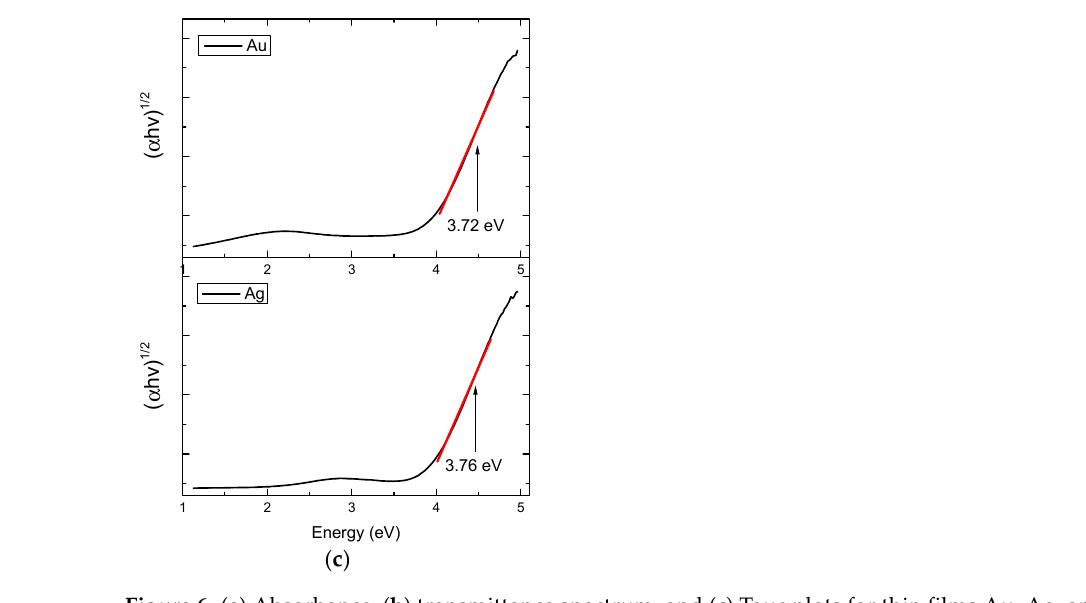
Figure 6. ( a ) Absorbance, ( b ) transmittance spectrum, and ( c ) Tauc plots for thin films Au, Ag, and Au-Ag-TiO 2 .